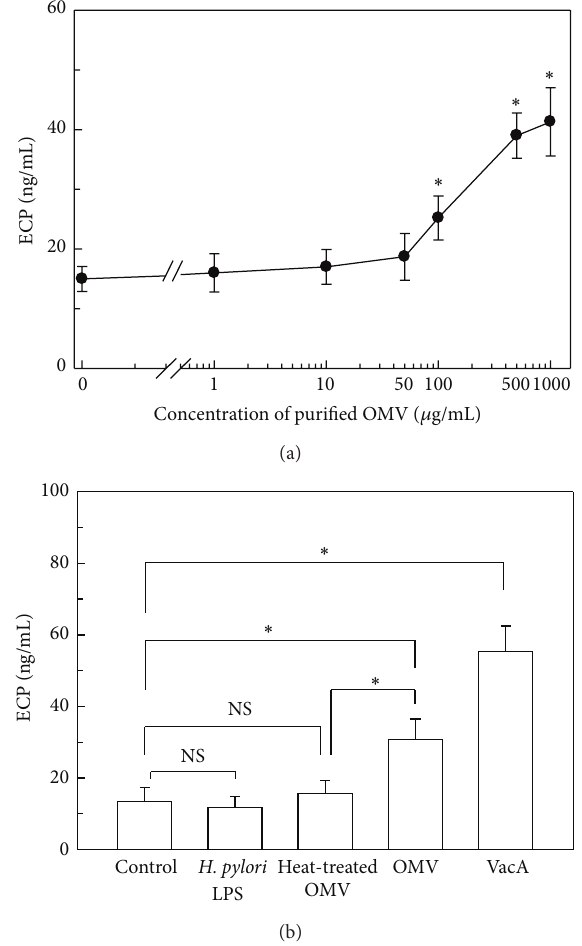
Figure 2: ECP release from eosinophils stimulated with intact H. pylori OMVs or individual components of OMVs. (a) ECP release is induced in a dose-dependent manner by H. pylori OMVs. Freshly isolated human eosinophils were treated with the indicated concentrations of H. pylori OMVs for 24 h. (b) Human eosino- phils were treated with H. pylori LPS (1,000 ng/mL), heat-treated OMVs (200 𝜇 g/mL), intact OMVs (200 𝜇 g/mL), or purified VacA (1,000ng/mL) for 24 h. The concentration of ECP in each culture supernatant was determined by ELISA (mean ± SEM, 𝑛 = 5 ). ∗ 𝑃 < 0.05 ; NS, statistically